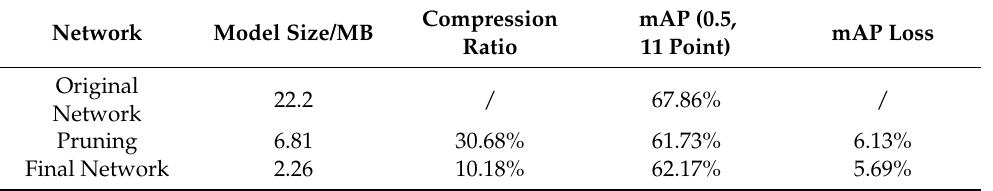
Table 4. SSD -MobileNet-v1 network compression results.